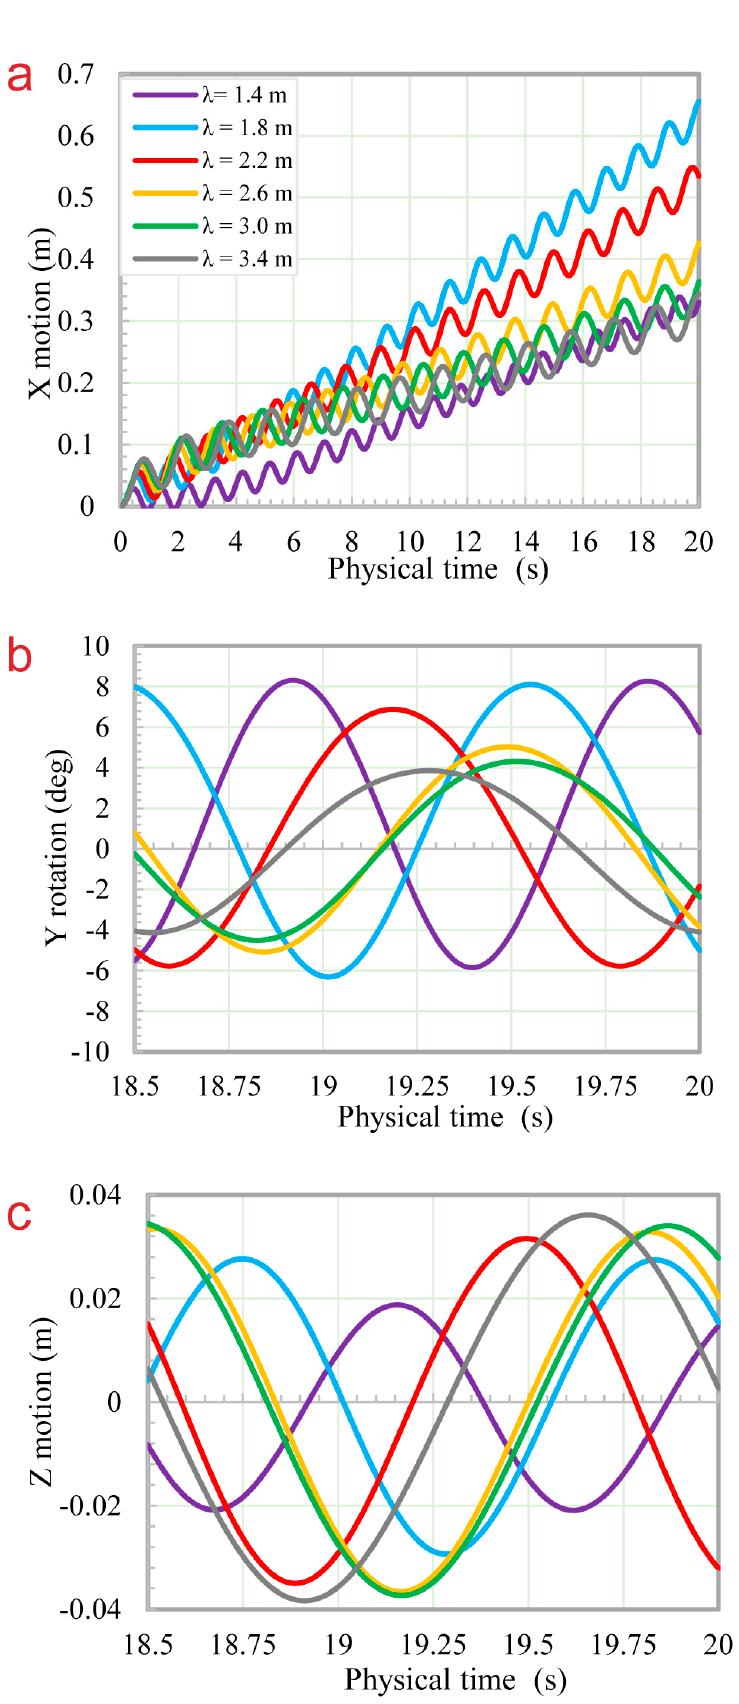
Figure 9. Ice floe motions along x, y, and z directions at different wavelengths. ( a ) X motion of ice floe; ( b ) Y rotation of ice floe; ( c ) Z motion of ice floe.